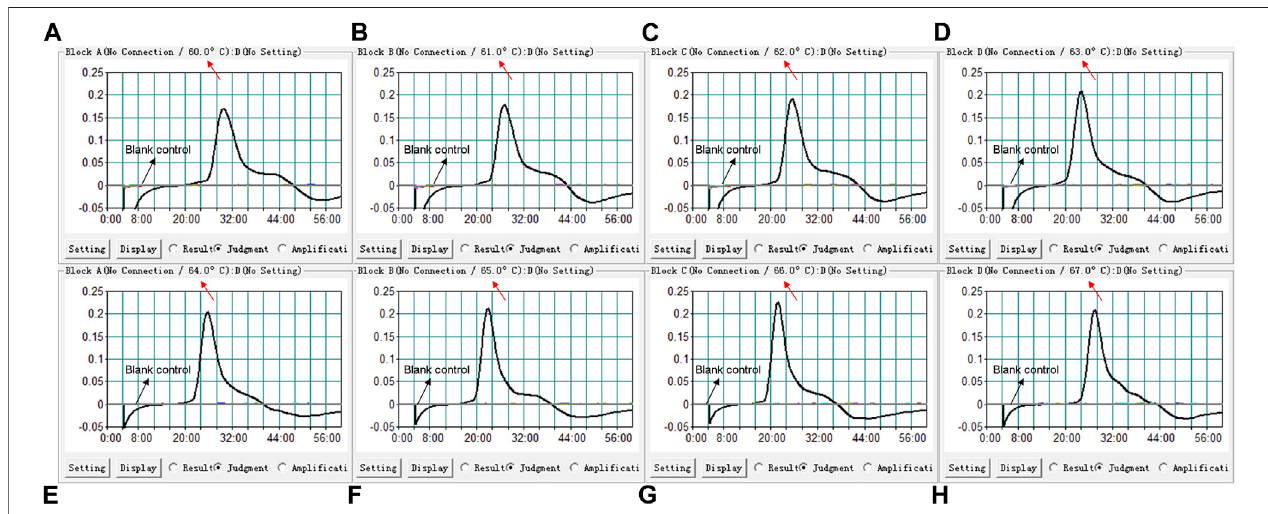
FIGURE 3 | Temperature optimization for the loop-mediated isothermal ampli fi cation (LAMP) assay. LAMP reactions detecting Bordetella pertussis were conducted using real-time turbidimetry and kinetic curves (A – H) at different temperatures ranging from 60 ° C to 67 ° C were acquired, showing that 66 ° C was optimal for the B. pertussis LAMP